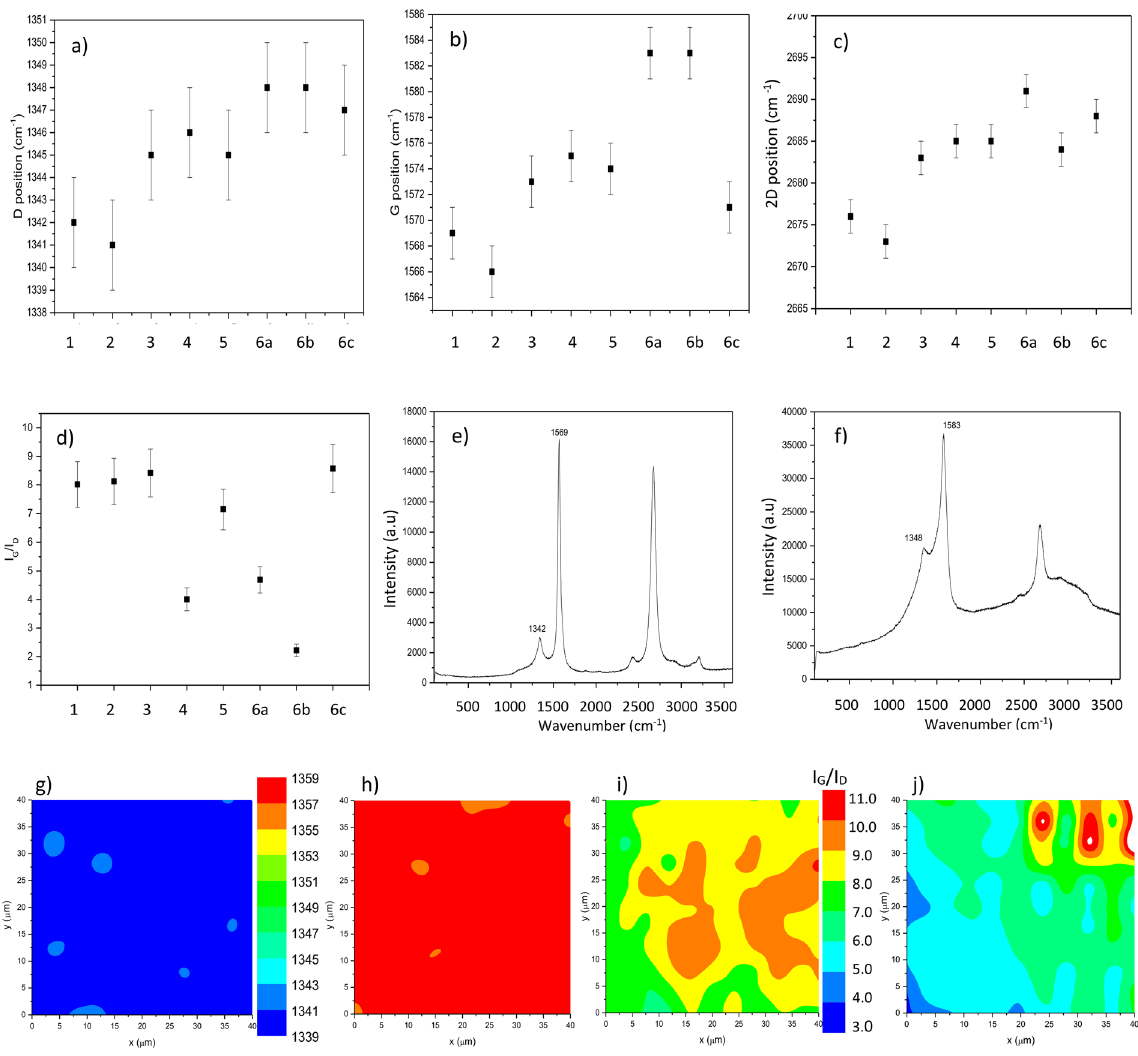
Figure 5. ( a ) Comparison of D- ( b ) G- ( c ) 2D-band position and ( d ) I G /I D ratio for all samples ( e ) Raman spectrum for as made and ( f ) H 2 SO 4 treated CNT wires; Raman maps of D-band position in ( g ) as-made fibre and ( h ) fibre doped with HClO 4 ; Raman maps of intensity marker (I G /I D ratio) in ( i ) as-made fibre and ( j ) fibre doped with HClO 4 . The error bars in Fig. 5a–c are related to the spectral resolution of the Raman spectrometer. While, in Fig. 5d, with the standard deviation of measurements of the integral intensity of Raman